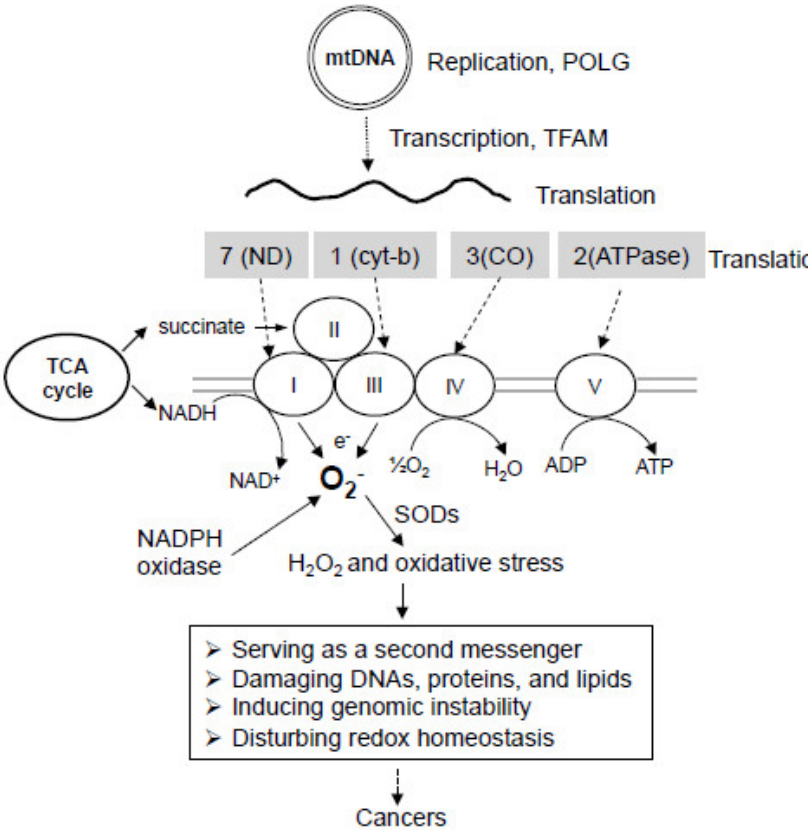
Figure 2. Mitochondrial genome, electron transport chain, and oxidative stress in cancer development. Mitochondria have their own supercoiled, double-stranded genome called mtDNA. Polymerase gamma (POLG) is the only polymerase responsible for mtDNA replication. Mitochondrial transcription factor A (TFAM) is responsible for mtDNA transcription. The products of mtDNA translation are all involved in the assembly of the mitochondrial respiratory chain, including complex I, complex III, complex IV, and complex V, while all components of complex II are encoded by nuclear DNA. NADH as a product of the TCA cycle feeds into complex I, while succinate as a substrate feeds into complex II of the electron transport chain. Electron leakage from complex I and III can be captured by molecule oxygen to generate superoxide (O 2− ), which may lead to oxidative stress. Mitochondrial dysfunction can also enhance NADPH oxidase (NOX) activity for the generation of O 2− . SODs can convert O 2− to H 2 O 2, which can be then converted to other forms of ROS. ROS can act as a second messenger to alter normal signaling cascades, or directly damage DNAs, proteins, and lipids, thus inducing genomic instability, redox imbalance, and the development of cancers and drug resistance.